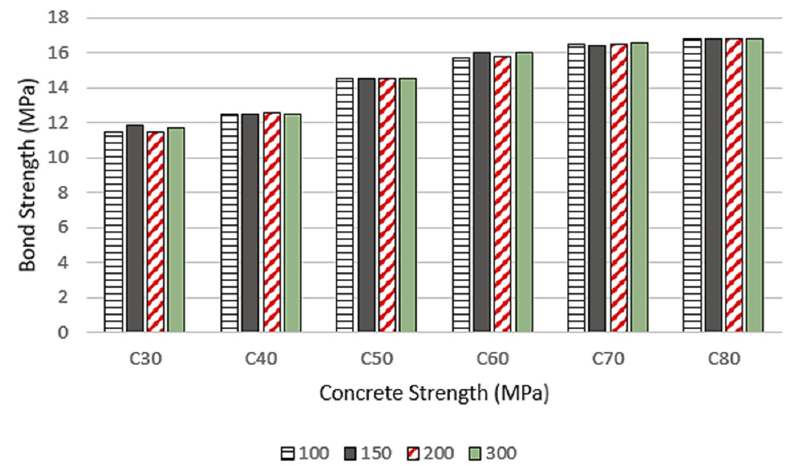
Figure 10. The effect of concrete strength on bond strength investigated with RC specimens (rebar diameter d16 of 16 mm and anchorage length ranging from 100 to 300 mm) [1].